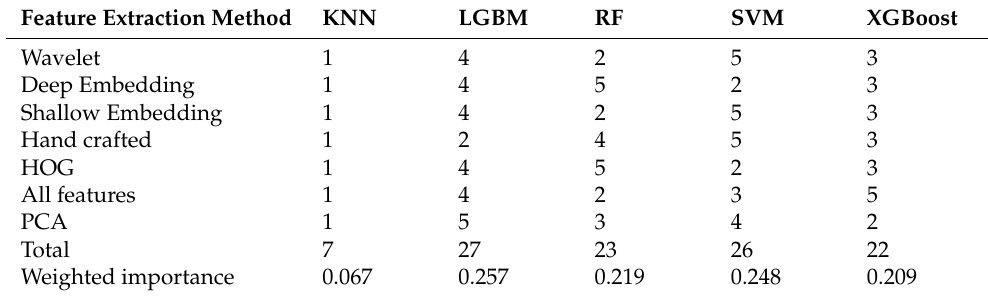
Figure 5. Confusion matrices for the best classifier trained using each feature set. ( a ) SVM using Wavelet transform; ( b ) Random Forest using deep embedding; ( c ) SVM using shallow embedding; ( d ) SVM using hand crafted features; ( e ) Random forest using HOG; ( f ) XGBoost on all features. Table 5. The ranking and calculated importance of classifiers taking part in